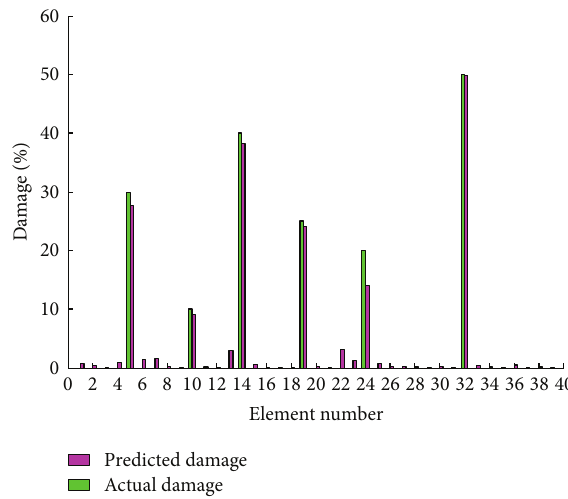
Figure 13: Damage distribution of plane frame using the complete noisy data in Scenario 2.